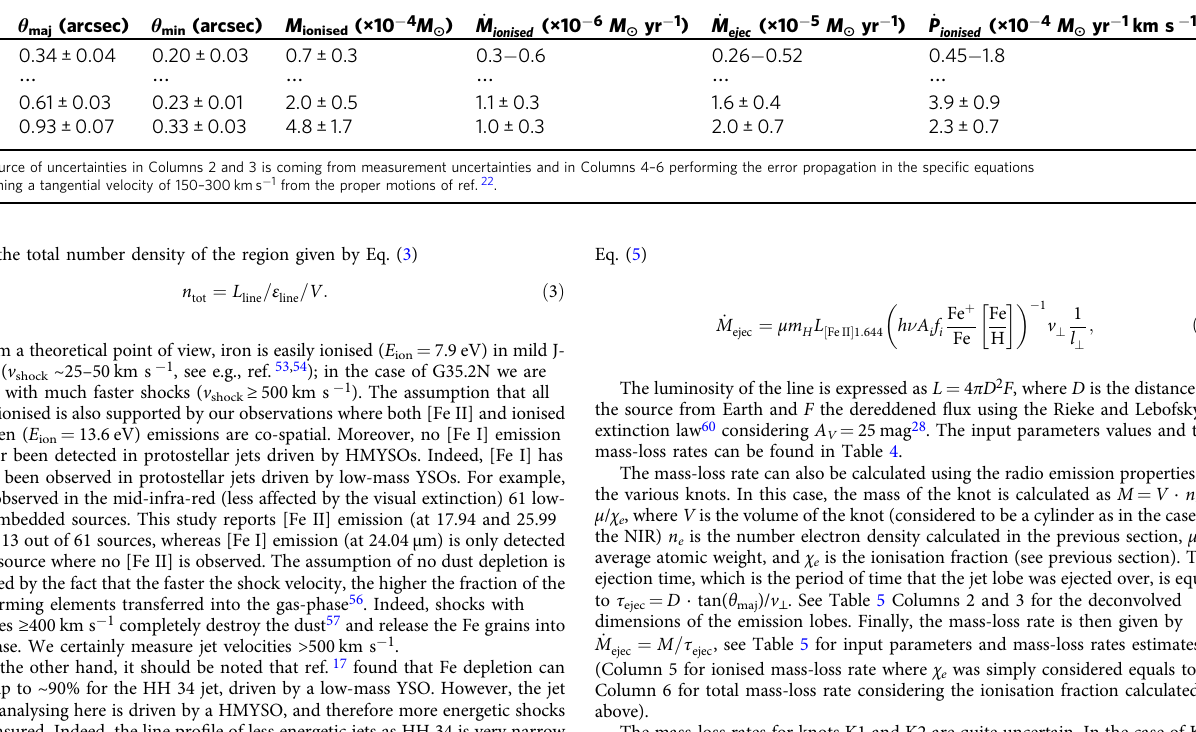
Table 5 Input parameters and mass-loss rates for the Radio C-band (6